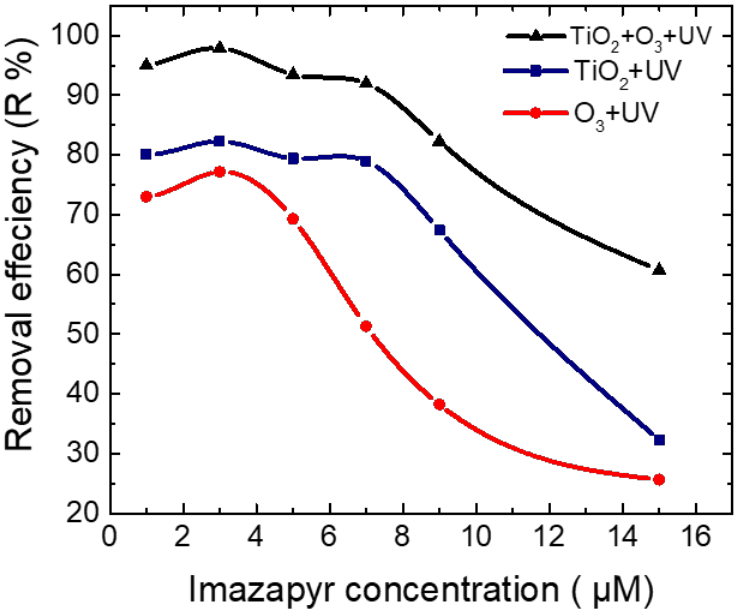
Figure 7. Removal efficiency as a function of imazapyr concentration, m TiO 2 = 50 mg; stirring speed = 1000 min −1 , aqueous suspension Milli-Q water.